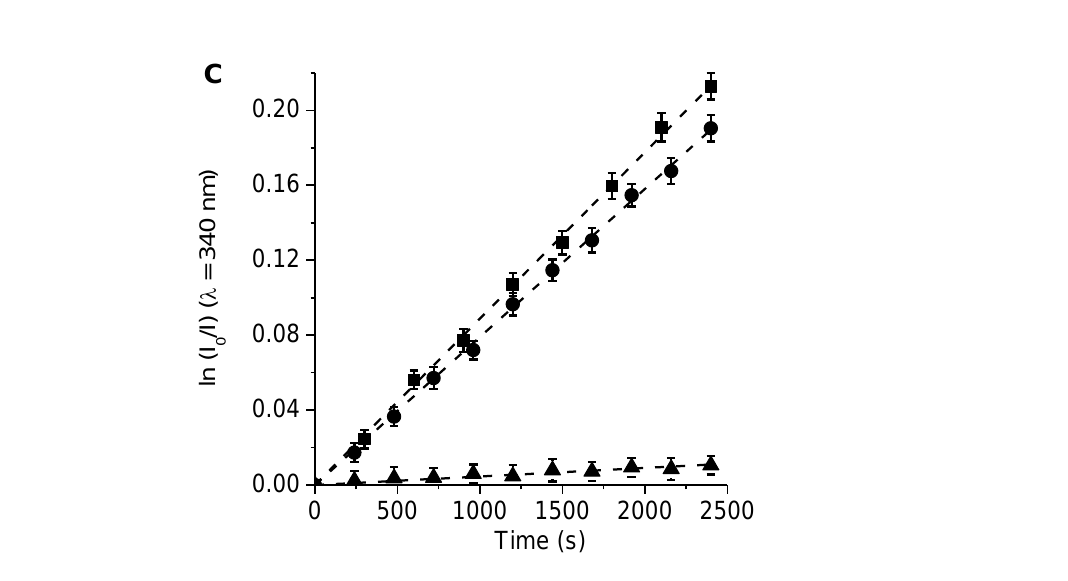
Figure 5. First-order plots for the photo-oxidation of Trp sensitized by porphyrins ( A ) 6 , ( B ) 7, and ( C ) TMP in DMF ( ■ ), λ irr = 517 nm; DMF/10% water ( λ ), λ irr = 350 – 800 nm; and DMF/10% water containing 100 mM KI ( π ), λ irr = 350–800 nm. Table 2. Kinetic parameters for the photo-oxidation of Trp (k obsTrp ) sensitized by 6 , 7, and TMP. Porphyrin